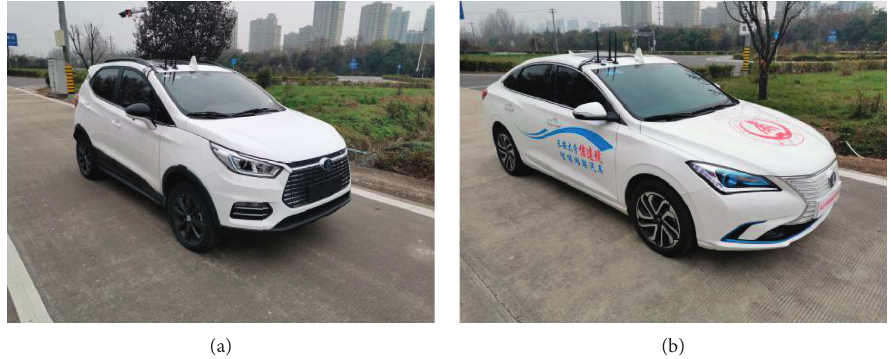
Figure 3: Tested vehicles equipped with test devices. (a) Tested vehicle 1. (b) Tested vehicle 2.